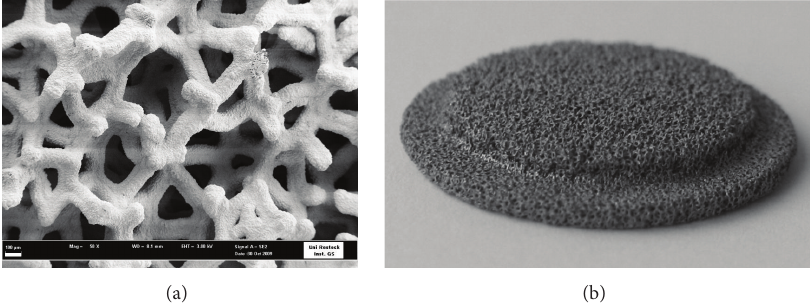
Figure 1: (a) Scanning electron microscopic (FESEM) image showing the pore structure of the Ta scaffold (magnification 50x, bar 100 𝜇 m). (b) Image of the molded Ta scaffold (radius: 14mm, center height: 5 mm). 2. Fixation1. Seeding